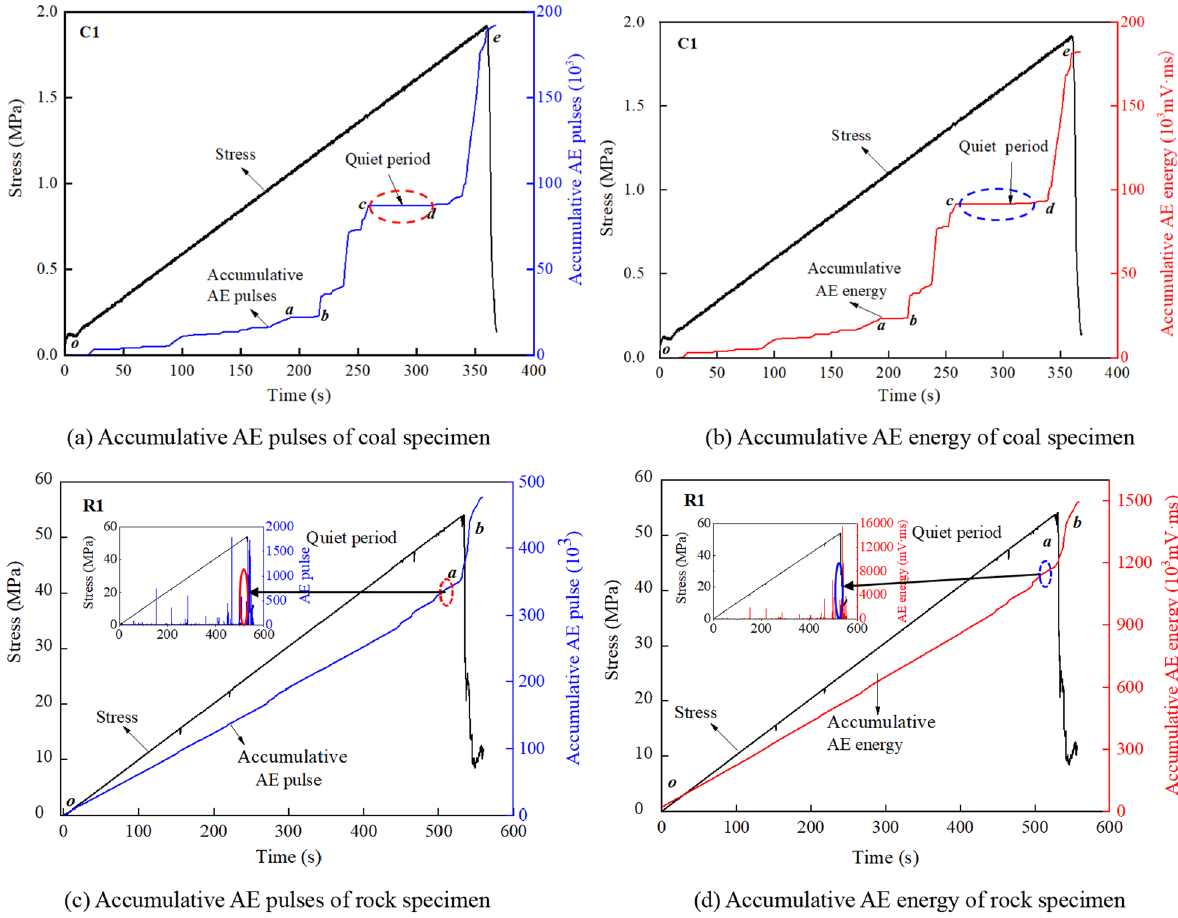
Fig. 4 Evolution law of AE response of coal and rock specimens under uniaxial